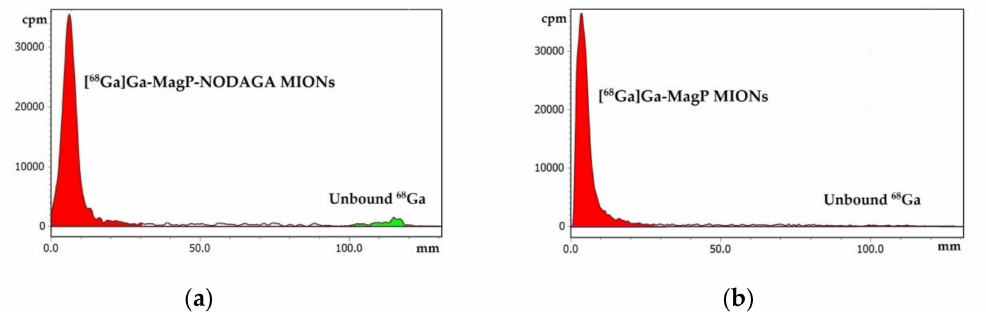
Figure 6. Radio-TLC chromatograms of 68 Ga labeling of: ( a ) MagP-NODAGA and ( b ) MagP MIONs. The peak at the spot area (first 30 mm) is attributed to the radiolabeled MIONs, whereas at the front, a small amount of unbound 68 Ga is detected. These results are acquired after 30 min of incubation.